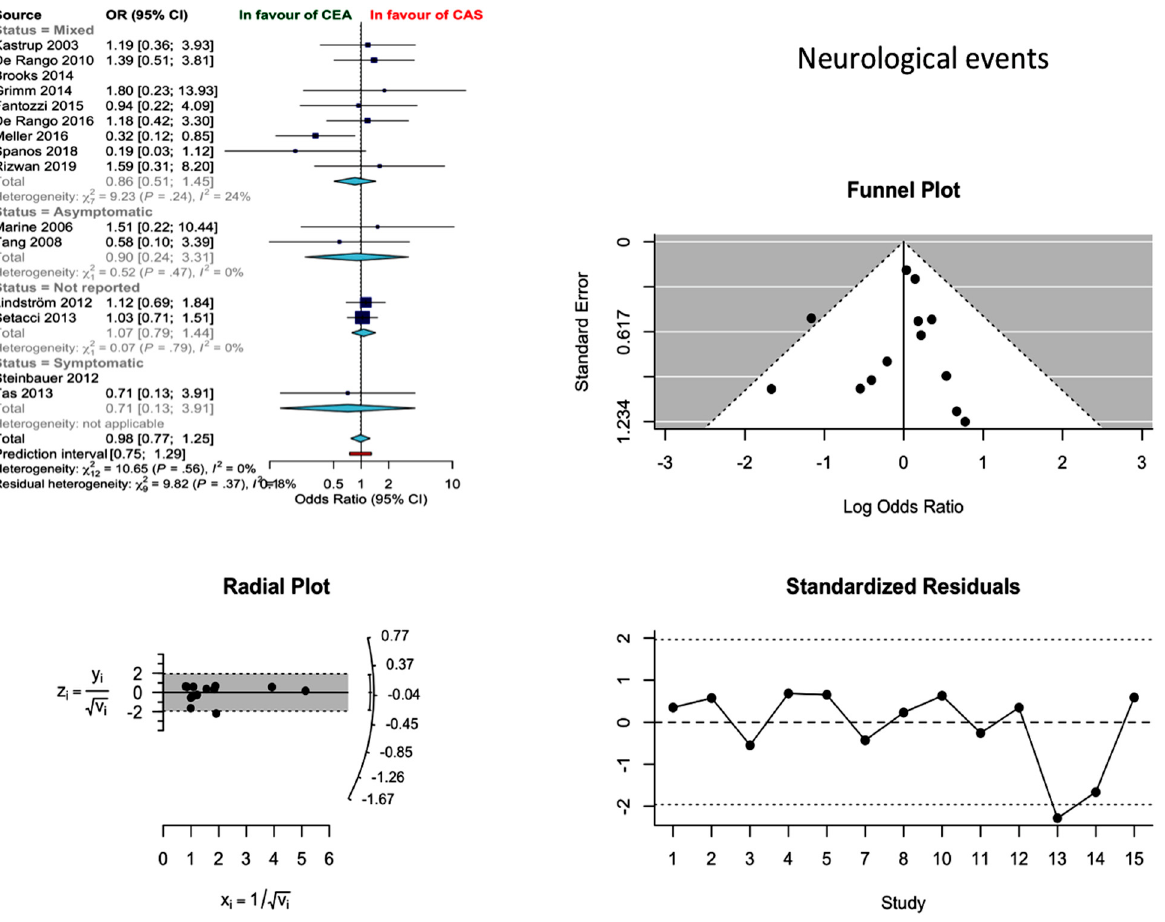
Figure 2. Differences in neurological event rate and related funnel plot between the CEA and CAS groups.